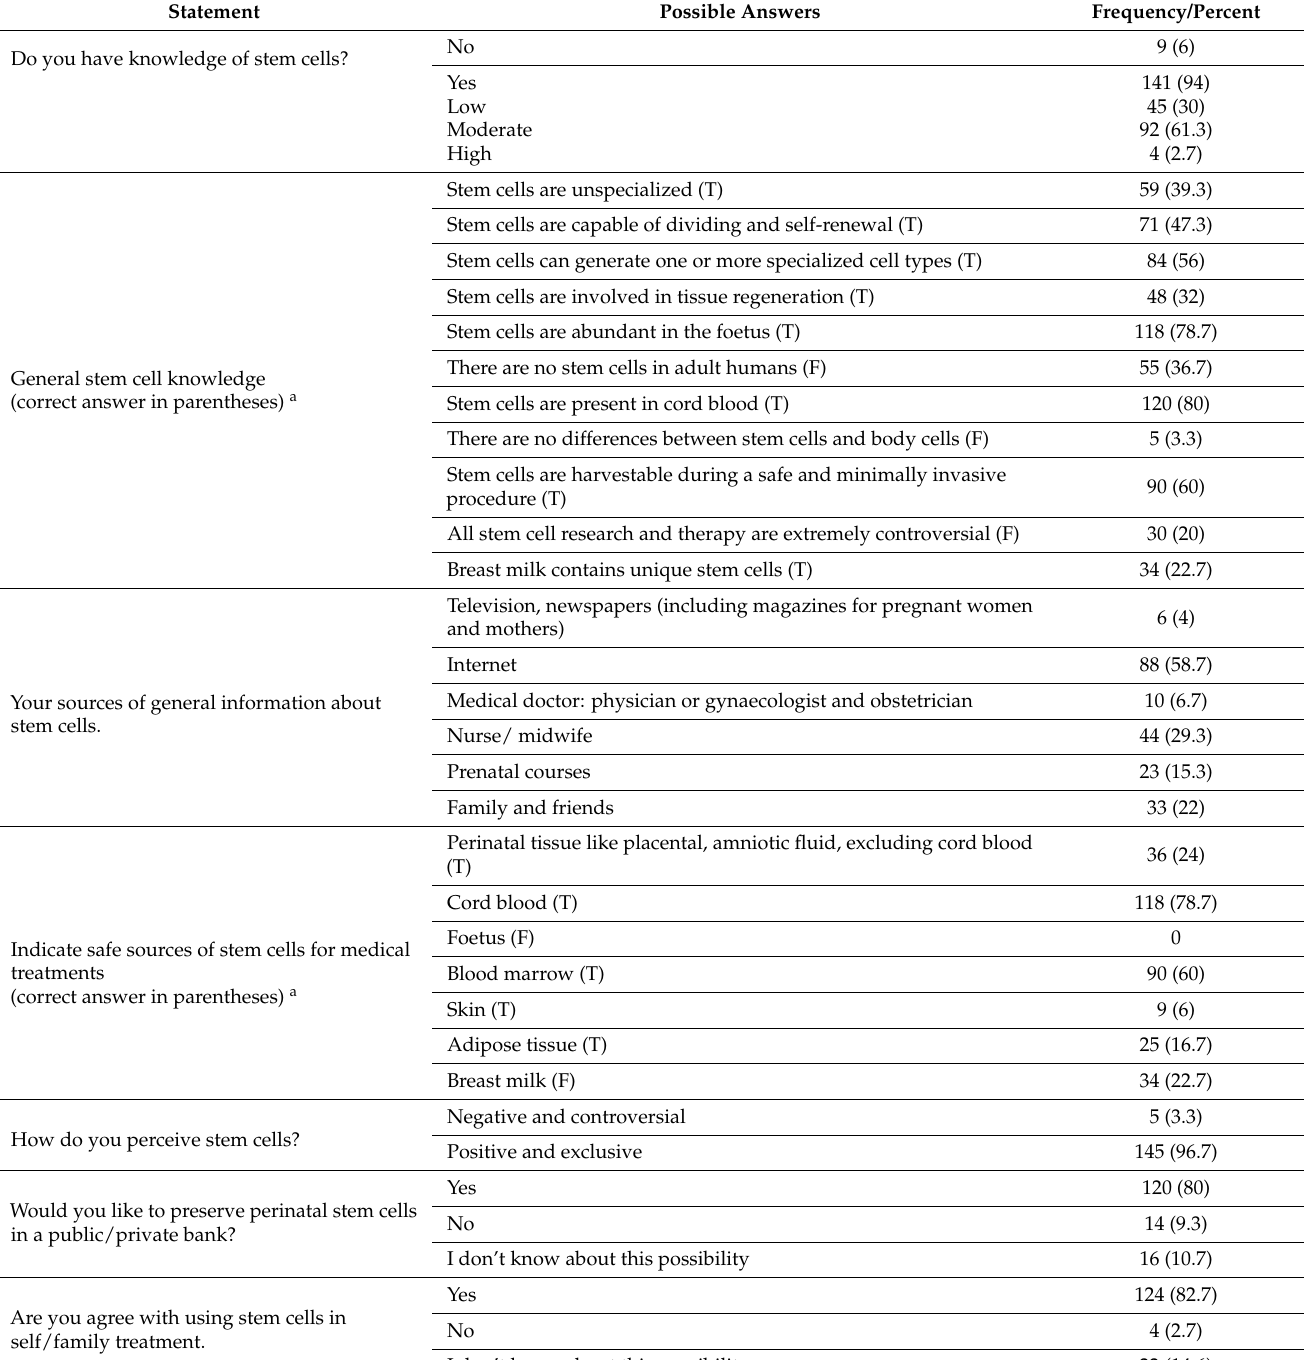
Table 2. Knowledge and perception of stem cells by pregnant women (n =